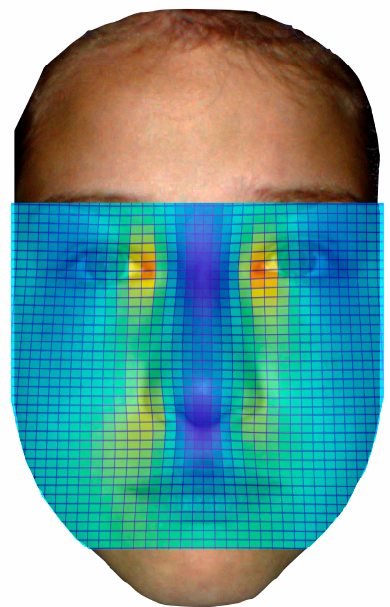
Figure 3. Visualization of significantly differing facial features via heat mapping with thin plate splines. Colors show significant differences for shorter inner canthal distance as well as shorter distance between sulci alares nasi and palpebral fissure length.